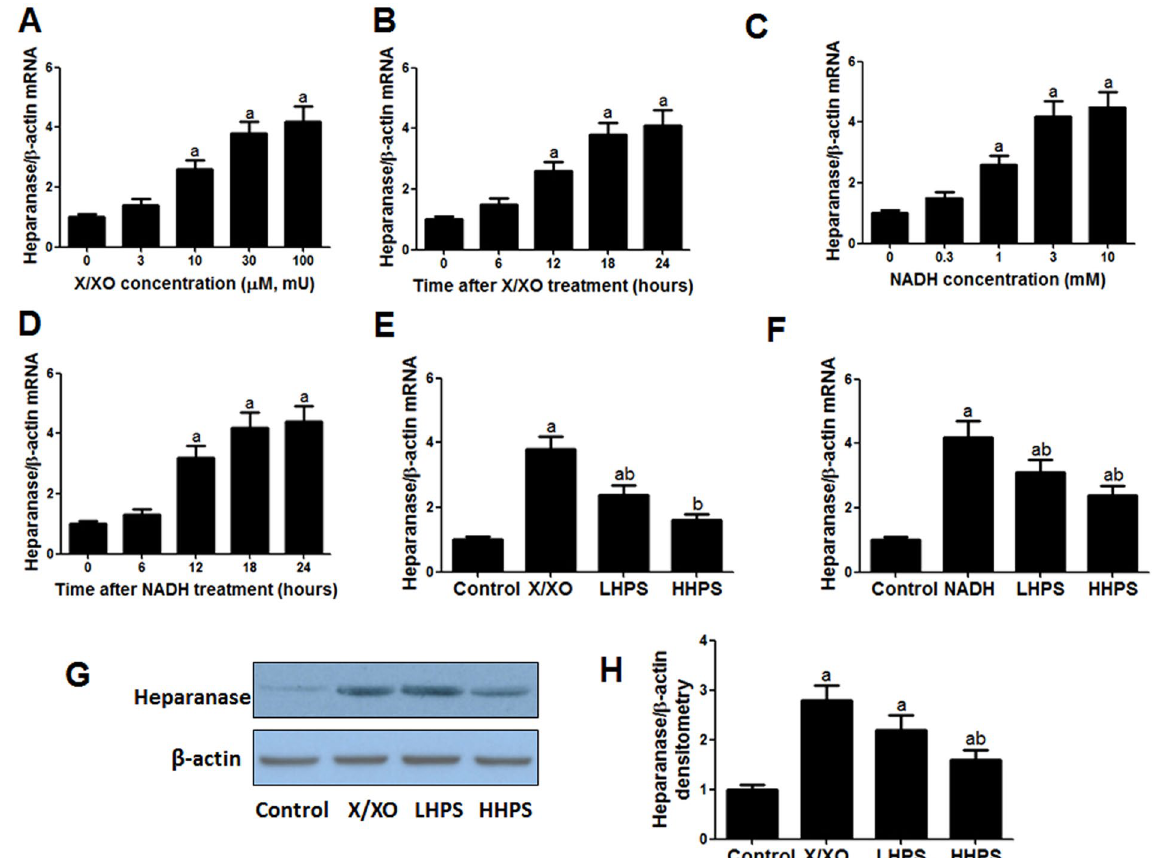
Figure 5. Hyperoside pre-treatment reduced the increased heparanase expression induced by ROS in cultured podocytes. ( A ) The dose-response effect of xanthine/xanthine oxidase (X/XO) on podocytes heparanase mRNA expression. Podocytes were incubated with 0, 3, 10, 30, 100 µ M xanthine plus equal doses of xanthine oxidase (mU) for 18 h. ( B ) The dose-response effect of NADH on podocyte heparanase mRNA expression. Cultured podocytes were incubated with 0, 0.3, 1, 3, 10 mM NADH for 18 h. ( C , D ) Podocyte heparanase mRNA expression after incubation with X/XO (30 µ M/mU) or NADH (3 mM) for 0, 6, 12, 18 and 24 h. ( E ) Hyperoside pre-incubation attenuated increased heparanase mRNA expression induced by extracellular ROS. Control: vehicle incubation for 18 h; X/XO: 30 µ M xanthine plus 30 mU xanthine oxidase incubation for 18 h; LHPS or HHPS: 30 or 100 μ g/ml hyperoside pre-incubation for 1 h and followed by X/XO (30 µ M/mU) exposure. ( F ) Hyperoside pre-incubation attenuated increased heparanase mRNA expression induced by intracellular ROS. Control: vehicle incubation for 18 h; NADH: 3 mM NADH incubation for 18 h; LHPS or HHPS: 30 or 100 μ g/ ml hyperoside pre-incubation for 1 h and followed by NADH exposure. ( G , H ) Hyperoside pre-incubation attenuated heparanase protein expression induced by X/XO by western blot analysis. The columns showed the amount of heparanse protein levels relative to β -actin. Control: PBS incubation for 24 h; X/XO: X/XO (30 µ M/ mU) incubation for 24 h; LHPS or HHPS: 30 or 100 μ g/ml hyperoside pre-incubation for 1 h and followed by X/XO (30 µ M/mU) exposure. Data are presented as mean ± SD. P < 0.05 is statistically significant. a Indicates significant vs. Control, b indicates significant vs.